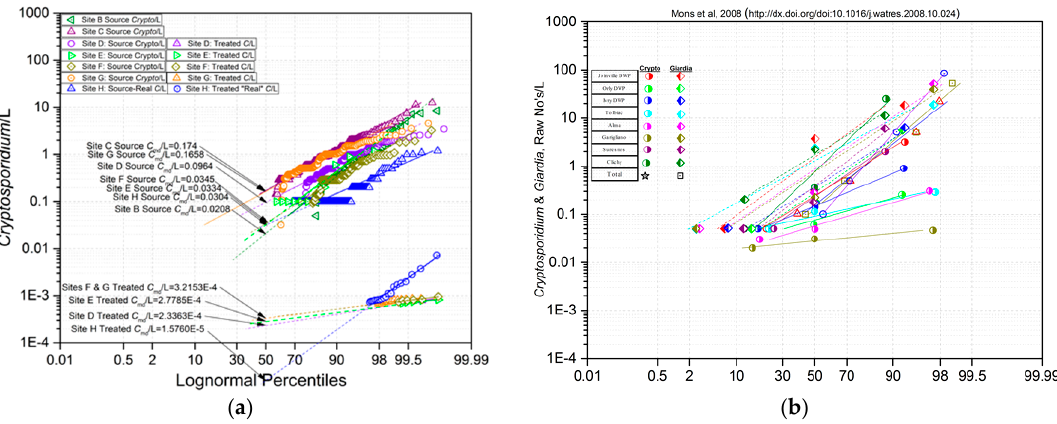
Figure 1. Cumulative frequency distributions of ( a ) Cryptosporidium /L at 8 sites in Britain, 1993–2004 (unpublished, from [2]; ( b ) Cryptosporidium /L and Giardia /L at 12 locations in France in 2005